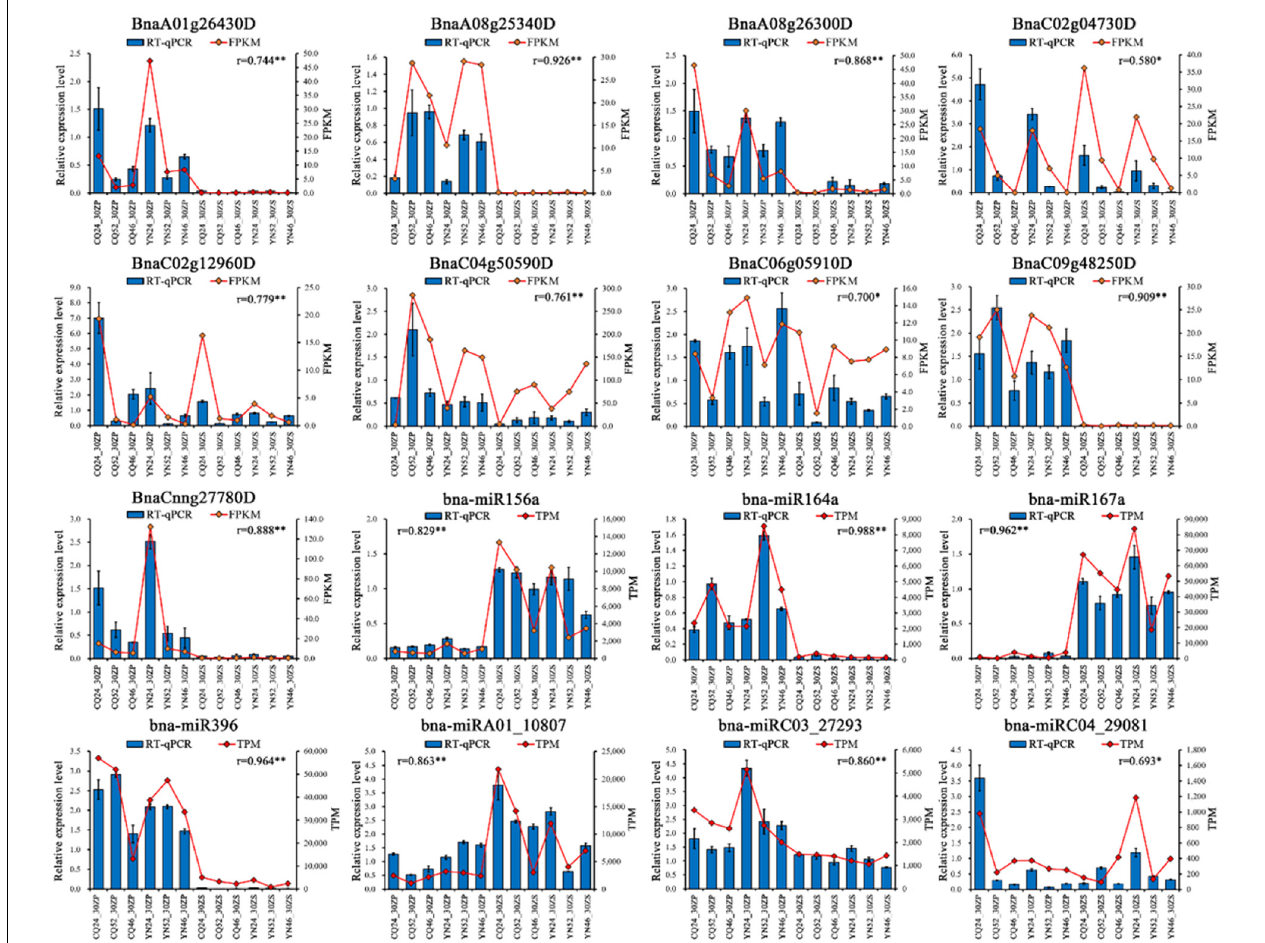
FIGURE 5 | RT-qPCR validation of DEGs and DEMs. Blue bars represent the relative expression level of RT-qPCR, and red points represent FPKM/TPM of sequencing; r represents Pearson correlation coefficient, *: correlation is significant at the 0.05 level, **: correlation is significant at the 0.01